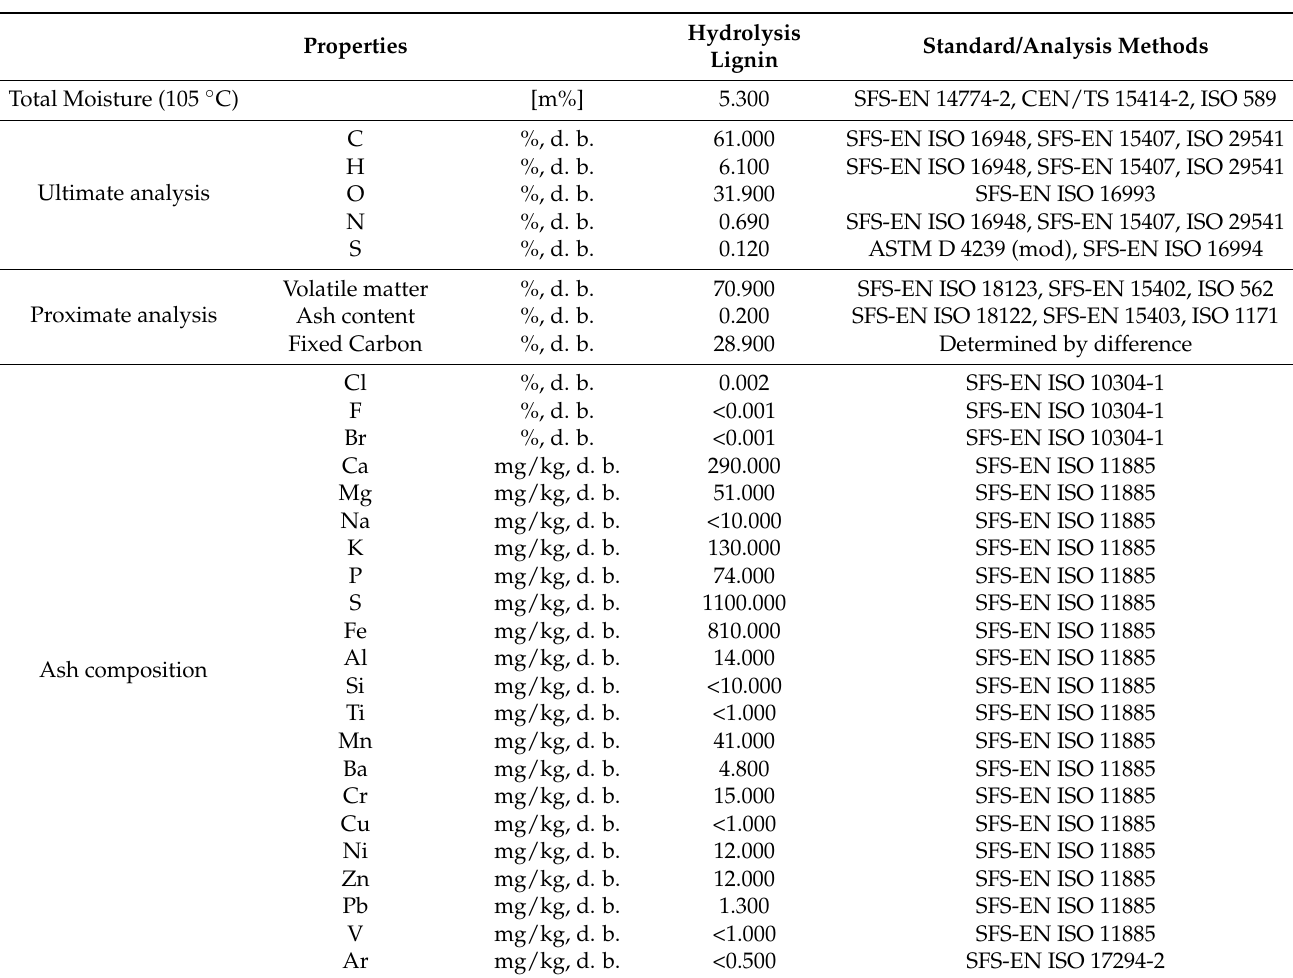
Table 1. Chemical properties of hydrolysis lignin. d. b.: dry